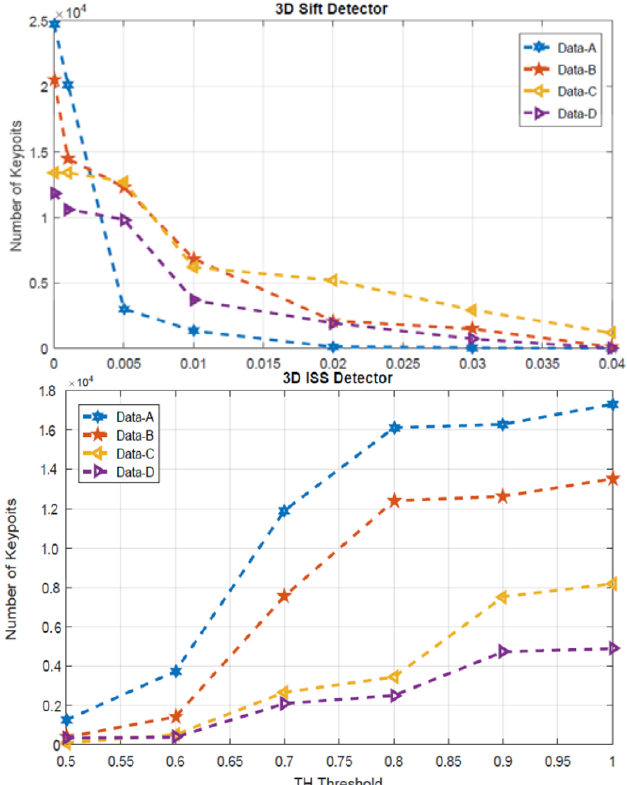
Figure 5. Effects of the T c and T h threshold on the number of extracted features in the standard 3DSIFT and 3DISS detectors. Data given in Figure 3.